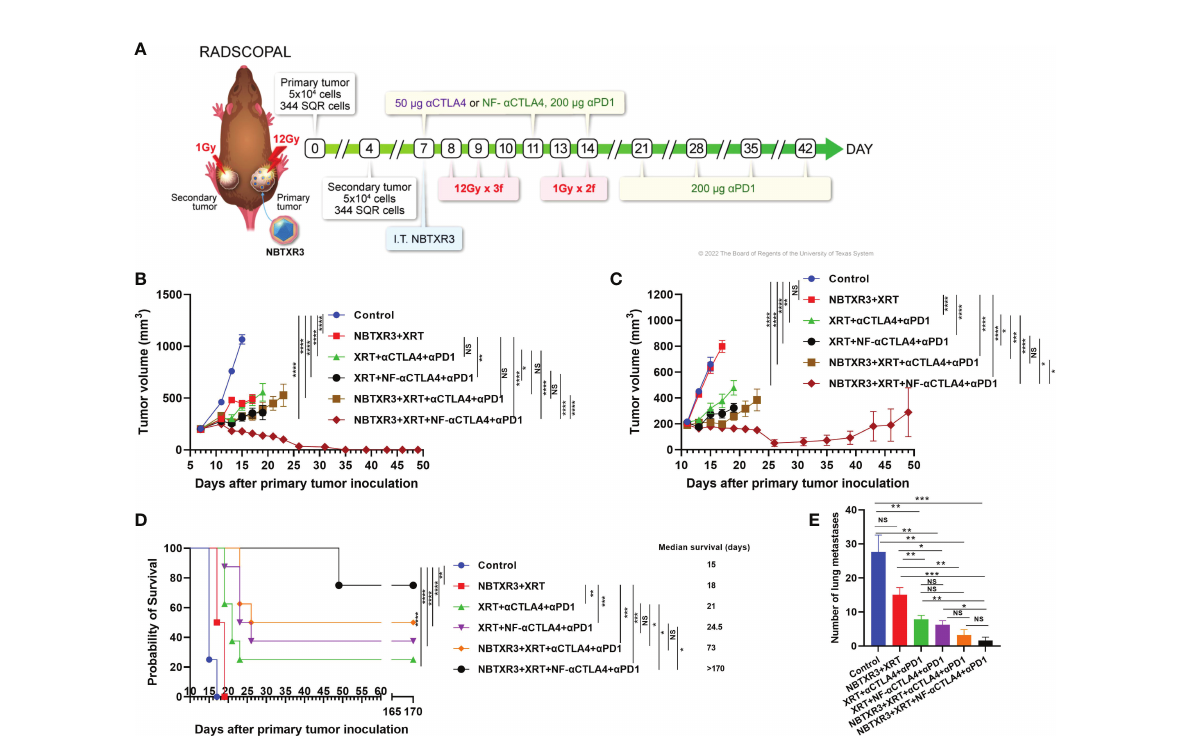
FIGURE 1 NF- a CTLA4, combined with NBTXR3-mediated immunoradiotherapy, signi fi cantly improves treatment ef fi cacy in a PD1-resistant lung cancer. (A) Treatment schema for combination therapies of NBTXR3, XRT, a CTLA4 or NF- a CTLA4, and a PD1. Mice were subcutaneously injected with 5×10 4 344SQR cells in the right legs on day 0 (to establish primary tumors, to be irradiated with high dose radiation) and in the left legs on day 4 (to establish secondary tumors, to be irradiated with low dose radiation). NBTXR3 was delivered to the primary tumor by intratumoral injection on day 7. Primary tumors were treated with three 12 Gy fractions on days 8, 9, and 10. Secondary tumors were irradiated with two 1 Gy fractions on days 13 and 14. a PD1 (200 m g) and anti-CTLA4 or NF- a CTLA4 (50 m g) were given by intraperitoneal injection on days 7, 11, and 14. a PD1 treatment was continued once a week from day 21 until day 42. For intratumoral injections of NF- a CTLA4, 50 m g of NF- a CTLA4 was intratumorally injected into the primary tumors on days 7 and 11. (B) Tumor volumes of the primary tumor. (C) Tumor volumes of the secondary tumor. (D) Survival rates and median survival time. (E) The number of spontaneous lung metastasis on day 16. Data are expressed as means± SEM. P<0.05 was considered statistically signi fi cant. *P<0.05, **P<0.01, ***P<0.001, ****P<0.0001, NS, not signi fi